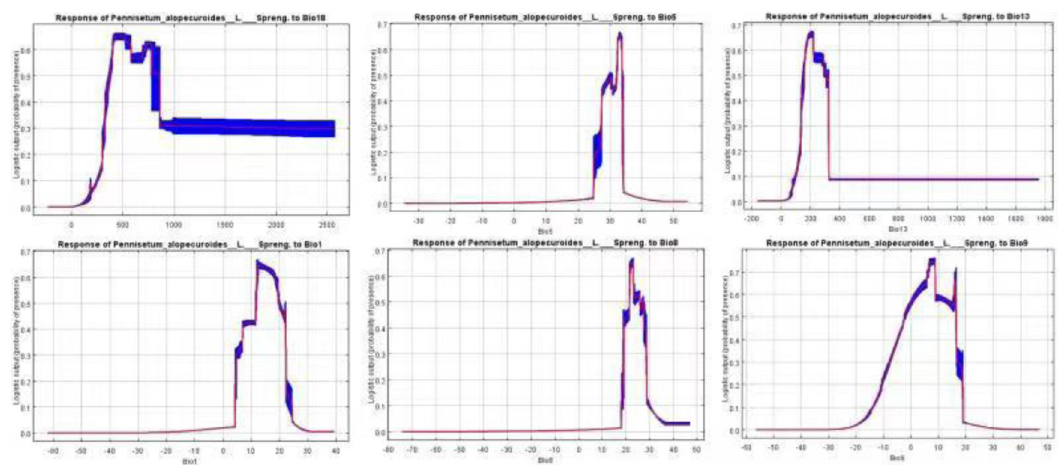
Fig 4. Response curves of climate suitability for the major environmental